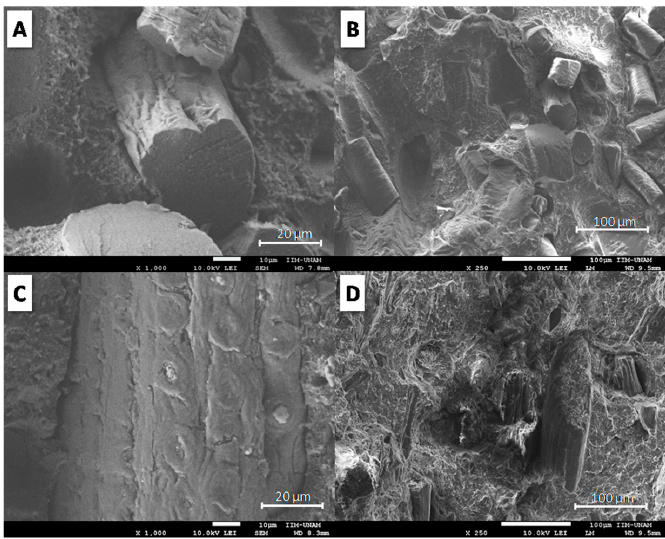
Figure 2. SEM micrographs of the fractured surface of TPS/20KF ( A , B ) and TPS/20CF ( C , D ) at two different magnifications.